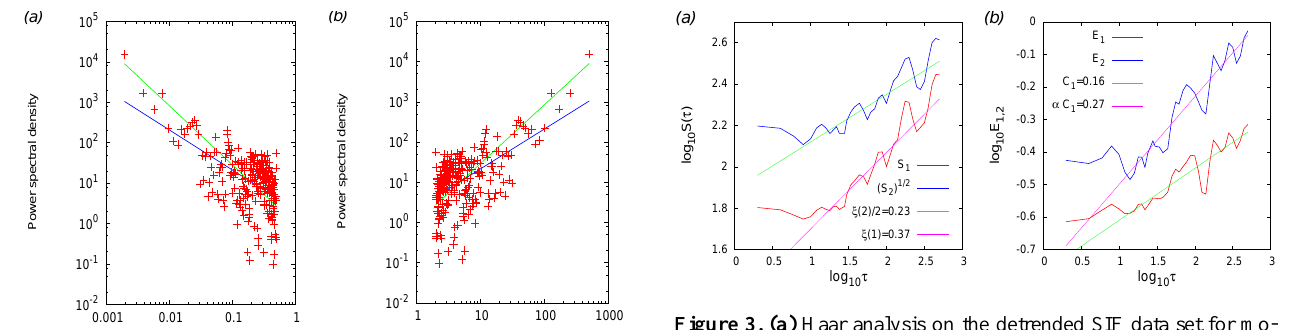
= ξ( 2 )/ 2 = 0 . 23 is quite different from the q = 1 exponent ( H ) and the data are far from Gaussian. In the classical quasi- Gaussian case, K(q) = 0 so that ξ(q) is linear. More